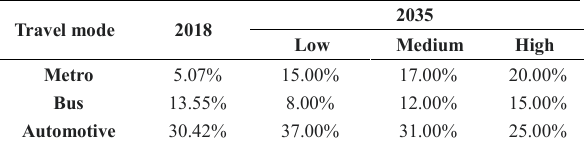
Table 5. Scenario setting of travel mode split